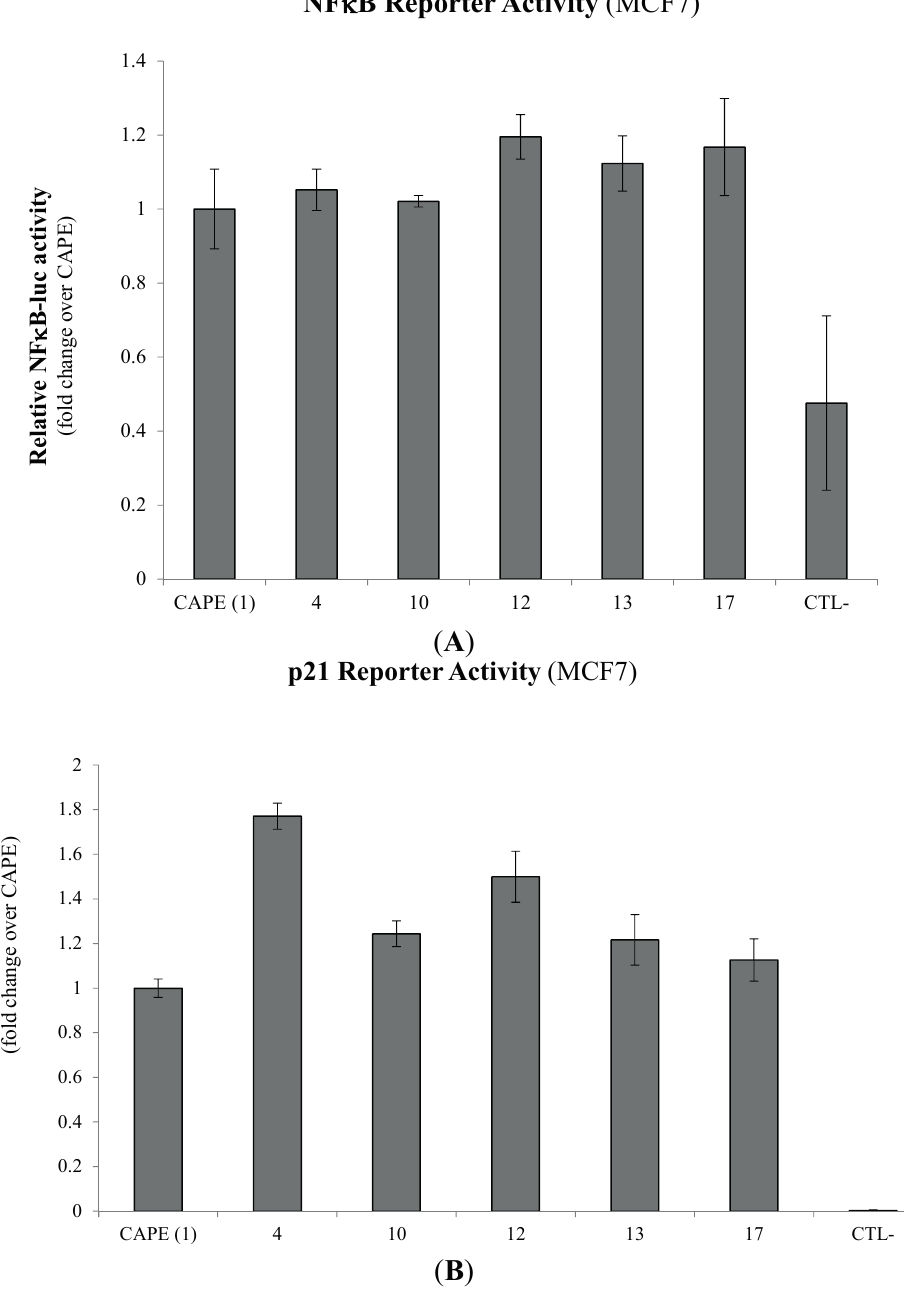
Figure 3. Modulation of cell fate regulators by selected CAPE analogs in breast cancer cells. MCF7 breast cancer cells were treated with 10 µM of selected compounds and evaluated for ( A ) NF κ B and ( B ) p53 transactivation potential using NF κ B-luciferase and p53-responsive p21-luciferase reporter gene constructs respectively. Relative light units (RLU) from normalized luciferase activity were then plotted in fold-change activity over the parent core CAPE compound. Control samples include the treatment with an IKK inhibitor (IKK-2 Inhibitor IV/10 µM) used as a positive control. Data is represented as means ± SEM of three experimental